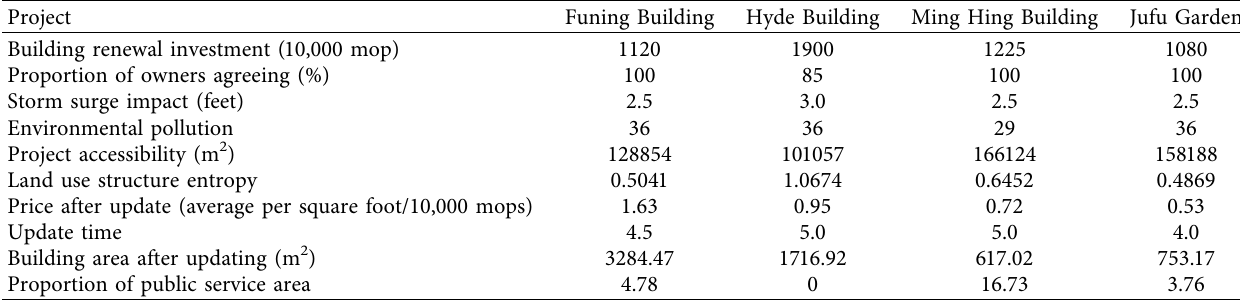
Table 6: DEA-based verifcation data of urban renewal site selection in Macau.